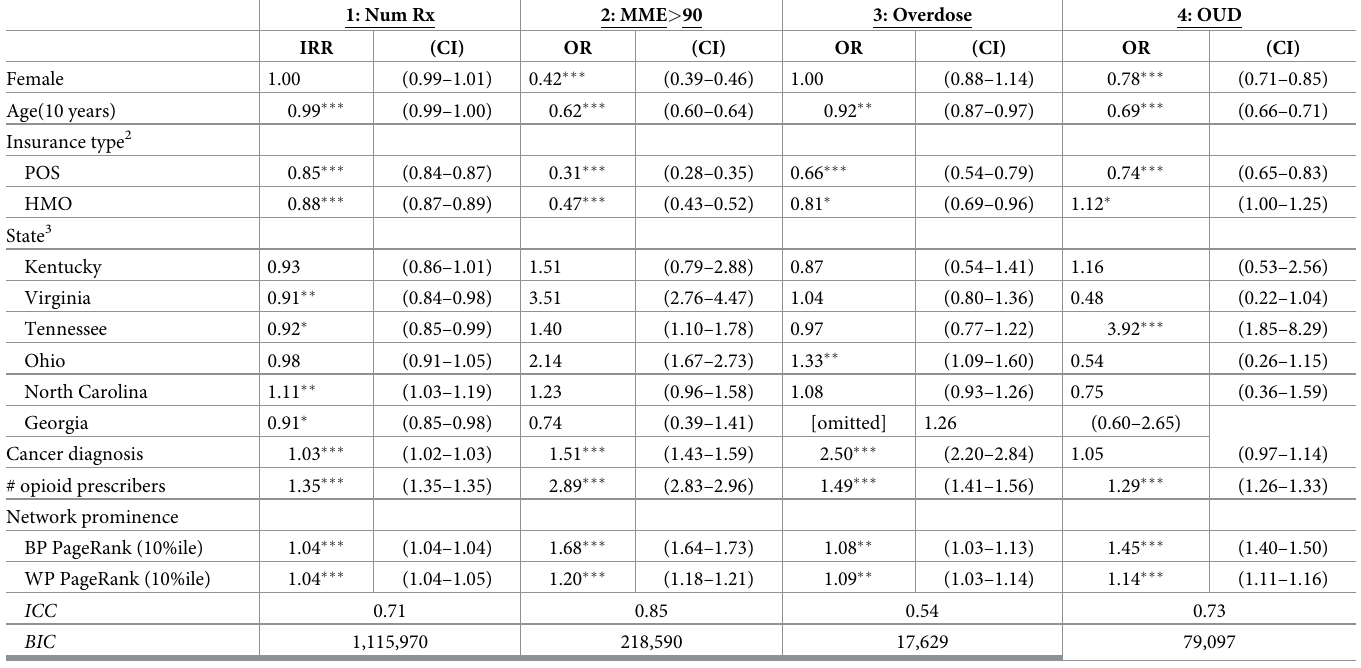
Table 3. Mixed effects regression 1 of opioid outcomes on between-person and within-person patient PageRank percentile and controls among high-risk patients with more than one prescriber per quarter (n = 68,401; n obs =